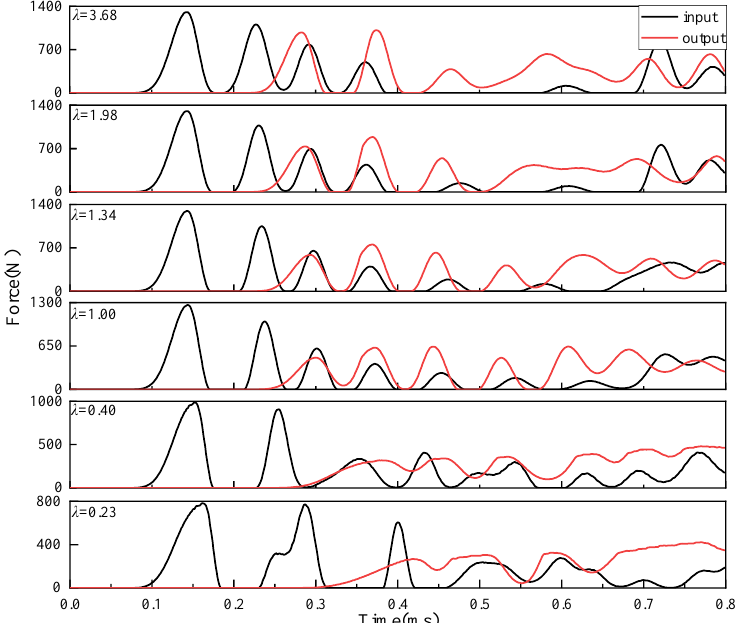
Figure 8. Contact force-time curves of Part II input interface and output interface under six cases.